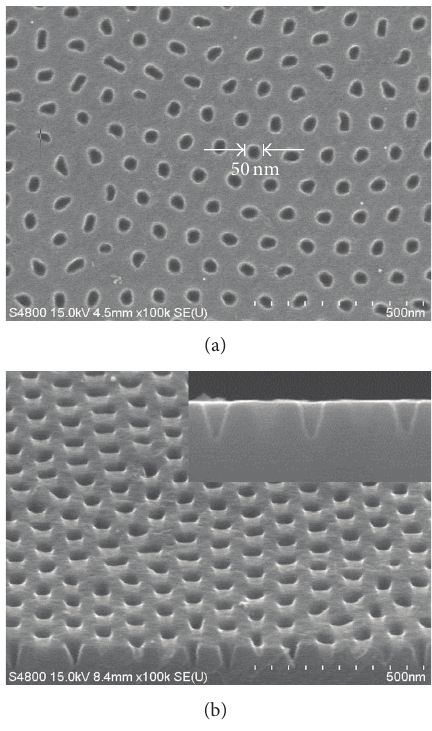
Figure 2: (a) Top- and (b) tilt-view FE-SEM images of the nanohole arrays formed on the InGaP window layer after ICP etching. The nanoholes have inverted-cone-shaped form with a top diameter of about 50 nm and a depth of about 64nm after 40 s etching. The inset